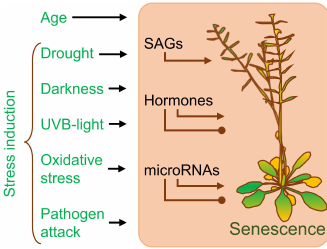
Figure 2. Senescence of a plant. Plant senescence is an age-related process influenced by various environmental factors. Senescence is regulated by hormones, microRNAs, and senescence-associated genes (SAGs). The arrows with triangular points reflect activation, and the arrows with circular tips reflect inhibition. UVB: ultraviolet